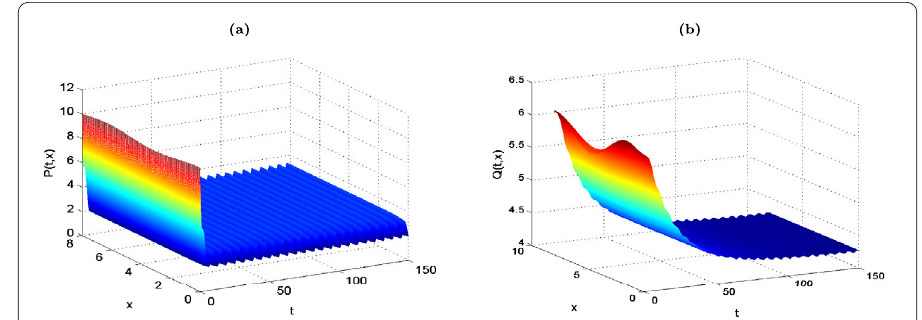
Figure 4 The periodic solution ( P ( t , x ), Q ( t , x )) with initial values P (0, x ) = 10 + 0.2sin( x ), Q (0) = 6 + 0.2sin( x ). ( a )–( b ): the densities of prey P ( t , x ) and predator Q ( t , x